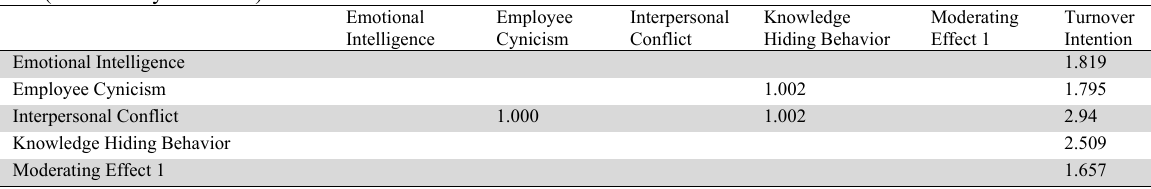
VIF (Collinearity Statistics) Inner VIF